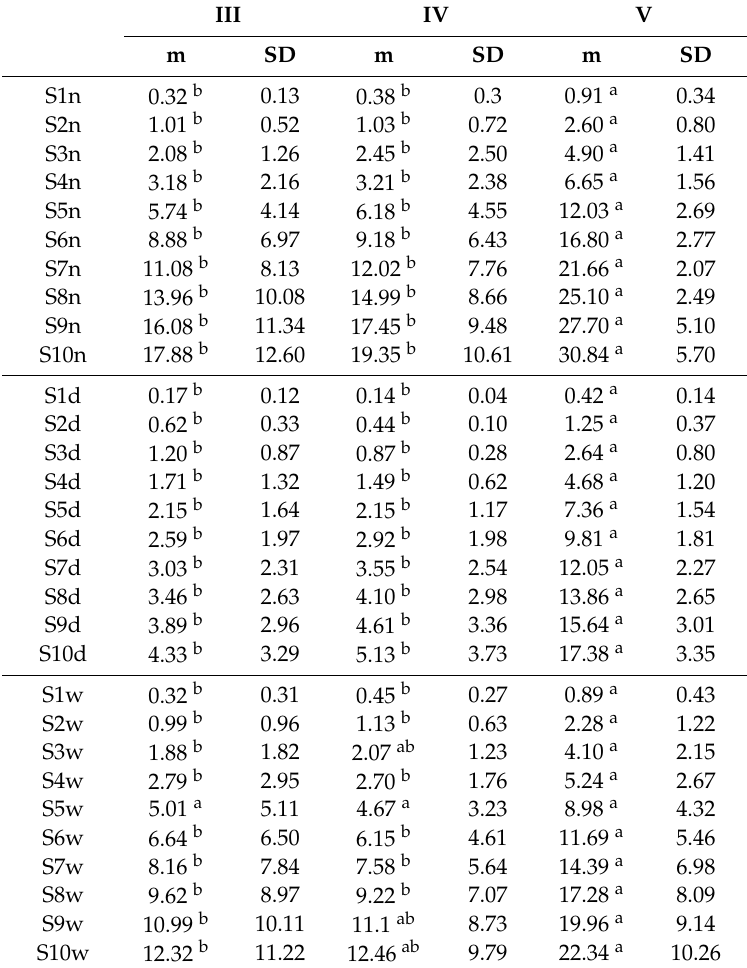
Table 2. Comparison of water storage capacity for each degree of deadwood decomposition at each stage of simulated precipitation.